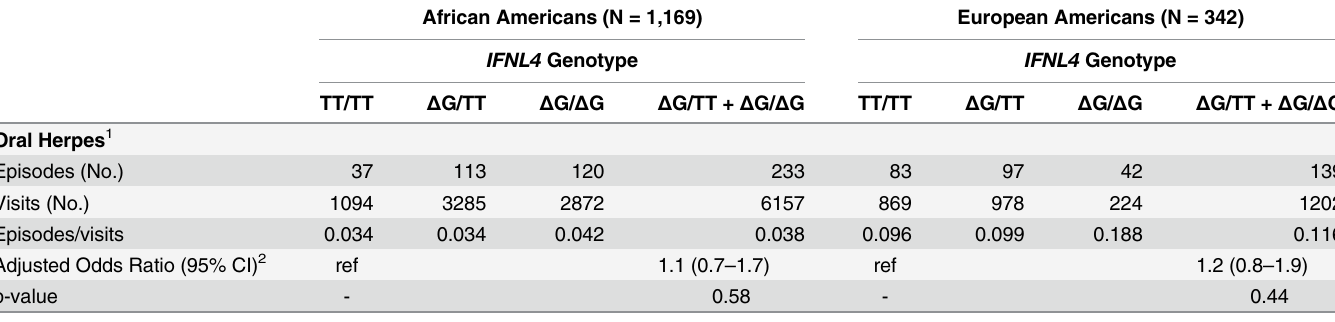
Table 3. Self-reported episodes of oral herpes among women enrolled in WIHS (1994 – 1995 cohort only), by race and IFNL4